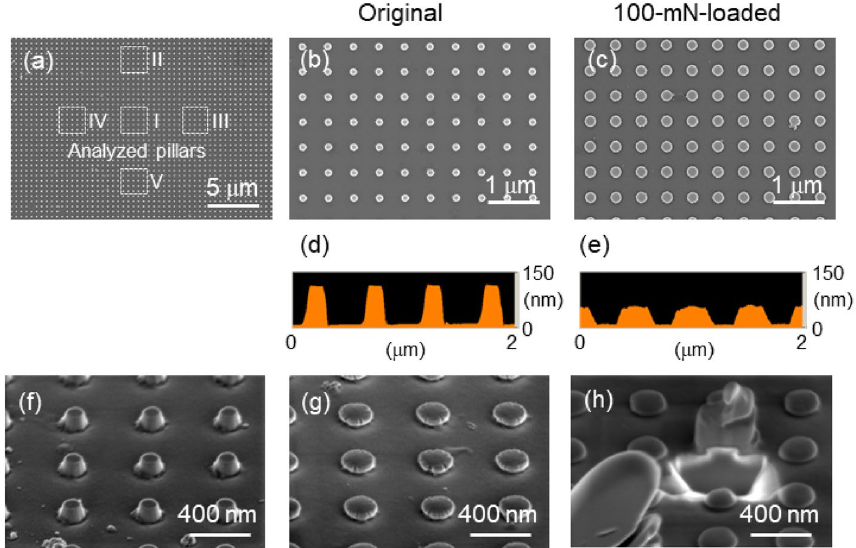
Figure 4. ( a – c ) Surface SEM images and ( d , e ) AFM height profiles of the ( b , d ) original D 100– H 100 SQ nanopillars and ( a , c , e ) the pillars after deformation at a peak load of 100 mN. ( f , g , h ) Tilted SEM images of the